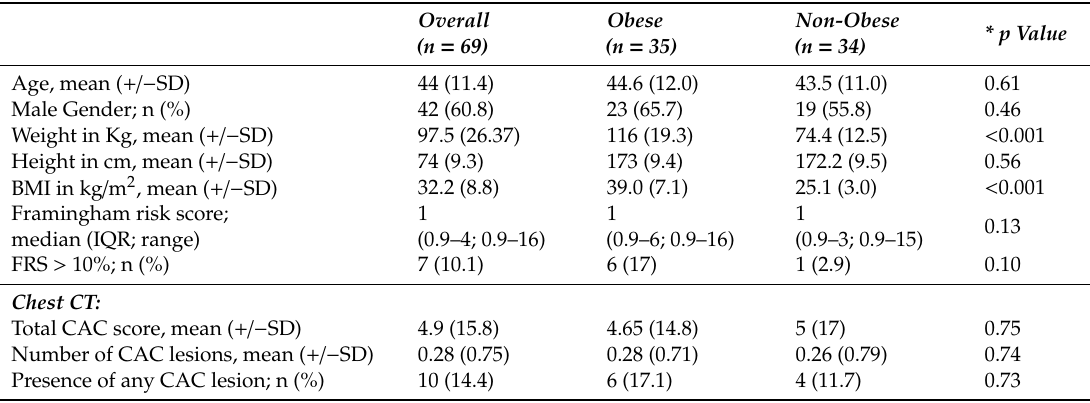
Table 1. Baseline demographic and biological